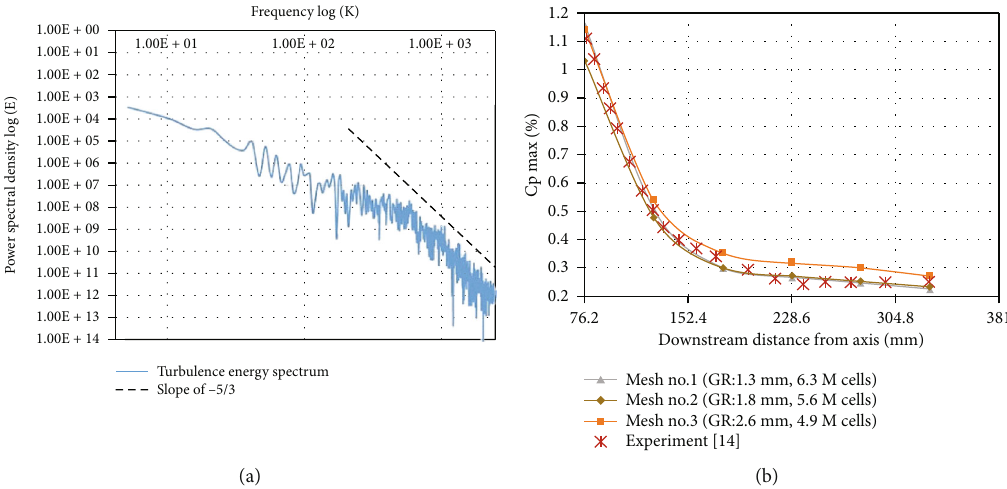
Figure 2: (a) Power spectral density obtained by current DES results on fi nest grid zone to study the Kolmogorov ’ s − 5/3 scale law requirements. (b) Solution-grid independency study conducted on the single 90 °